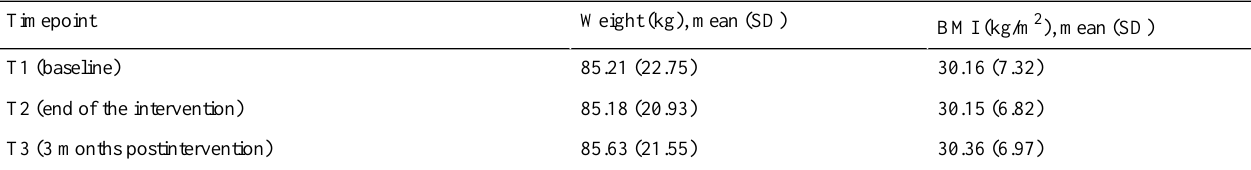
occurred. These differences from T1 were maintained at follow-up at T3 (DES score: MD 0.72; P< .001 and DDS score: MD −0.6; P= .002; Figures 5 and